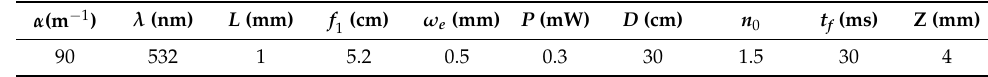
Table 1. The considered parameters used for the simulation.